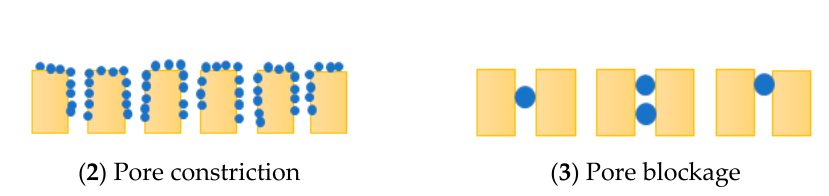
Figure 3. Mechanism of fouling. Reversible fouling: ( 1 ) Cake layer formation, ( 2 ) pore constriction. Irreversible fouling: ( 3 ) pore blockage.